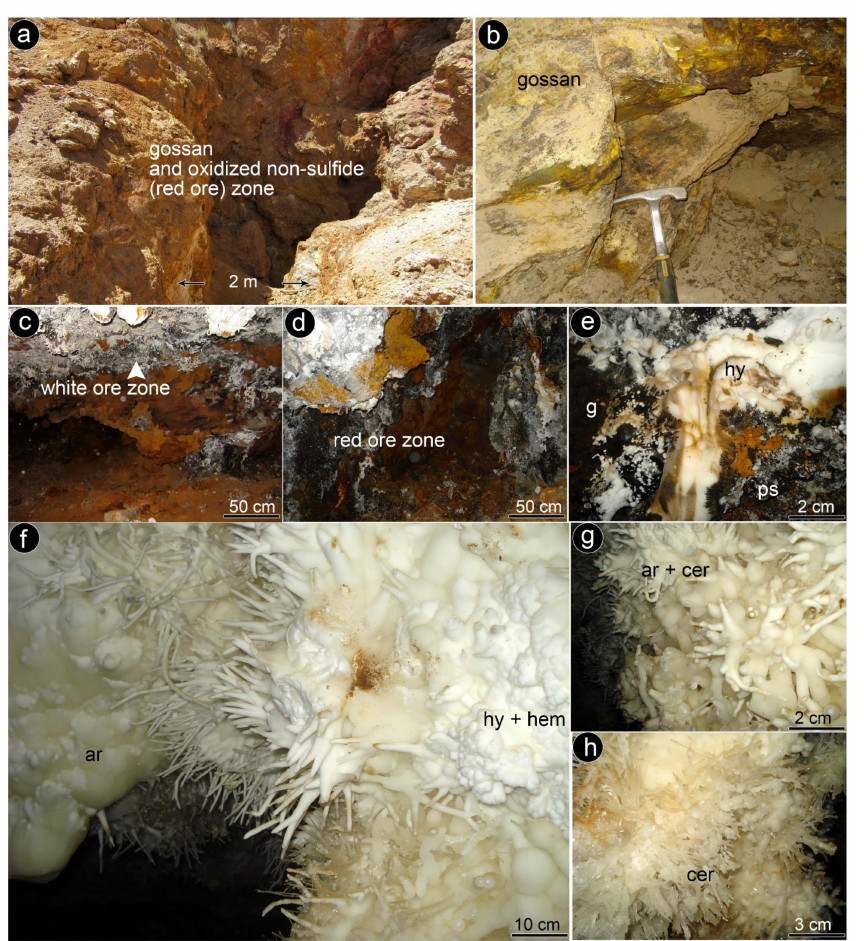
Figure 12. General view of the oxidized and supergene non-sulfide mineralization in the Ab-Bid de- posit. ( a , b ) Gossan and oxidized non-sulfide (red ore) zone outcrops on the ground and underground caves. ( c – e ) Outcrop photographs of the red ore and white ore zones in underground tunnels and cavities. ( f – h ) Radial and euhedral cerussite (cer), aragonite (ar), hydrozincite (hy), and hemimorphite (hem) growing on the cavity walls and cave; pe: